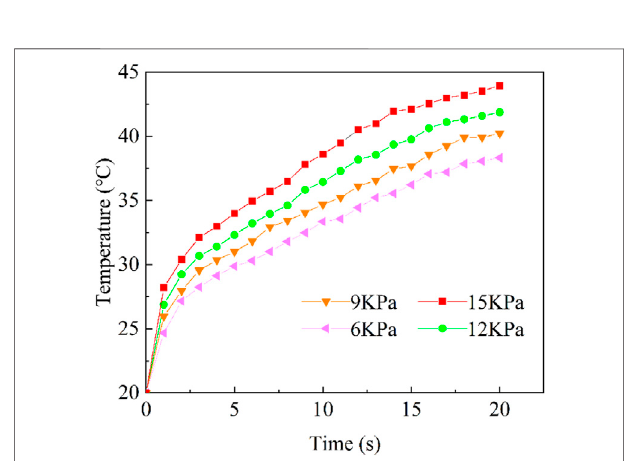
FIGURE 6 | The relationship between temperature and